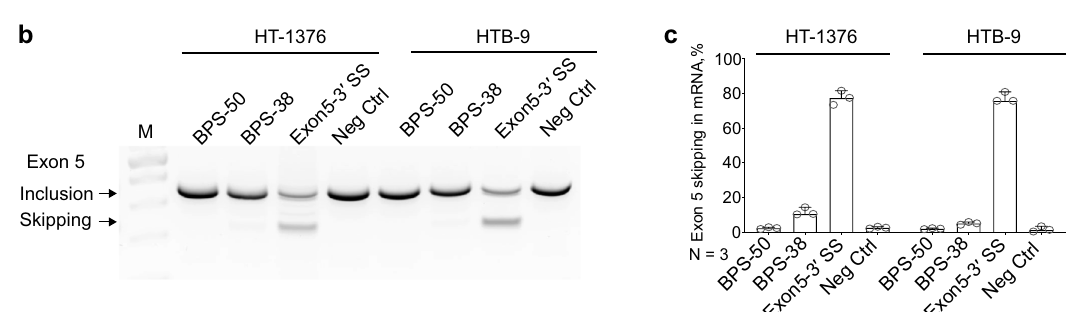
Fig. 7 Splice-switching oligonucleotides (SSOs) for inducing A3B exon 5 skipping. a Schematic representation of the A3B splicing module that includes exons 4 – 6. The splice sites (SS), branch point sites (BPS), and SSOs for intron 4 BPS (positions − 50 and − 38 bp) and 3 ′ SS of exon 5 are depicted. b A representative agarose gel showing RT-PCR products of exon 5 inclusion and skipping in two bladder cancer cell lines (HT-1376 and HTB-9) that were nucleofected with 2 nM of SSOs. c Bar graphs based on image analysis of b , showing the % of A3B exon 5 skipping. Error bars represent 95% con fi dence intervals for the medians, based on three biological replicates. SSO-3 ′ SS resulted in exon 5 skipping in ~80% of A3B